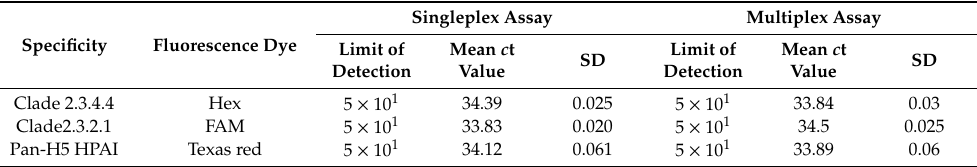
Figure 2. Amplification plots and standard curves of the singleplex and multiplex realtime-qPCR assays using target-specific plasmid DNA. Comparison of the singleplex ( A , C , E ) and multiplex ( B , D , F ) realtime-qPCR assays was performed using standard plasmids corresponding to H5 HPAI clades 2.3.4.4 and 2.3.2.1; each plasmid solution was serially diluted down to 5 × 10 8 to 5 × 10 0 copies of plasmid DNA/microliter. The cycle threshold in amplification plots, correlation coefficient (R2) and slope of the standard curve for the assays were drawn automatically by Lightcycler 96 software. Each concentration had triple replicates. Table 1. Sensitivity of the single and multiplex